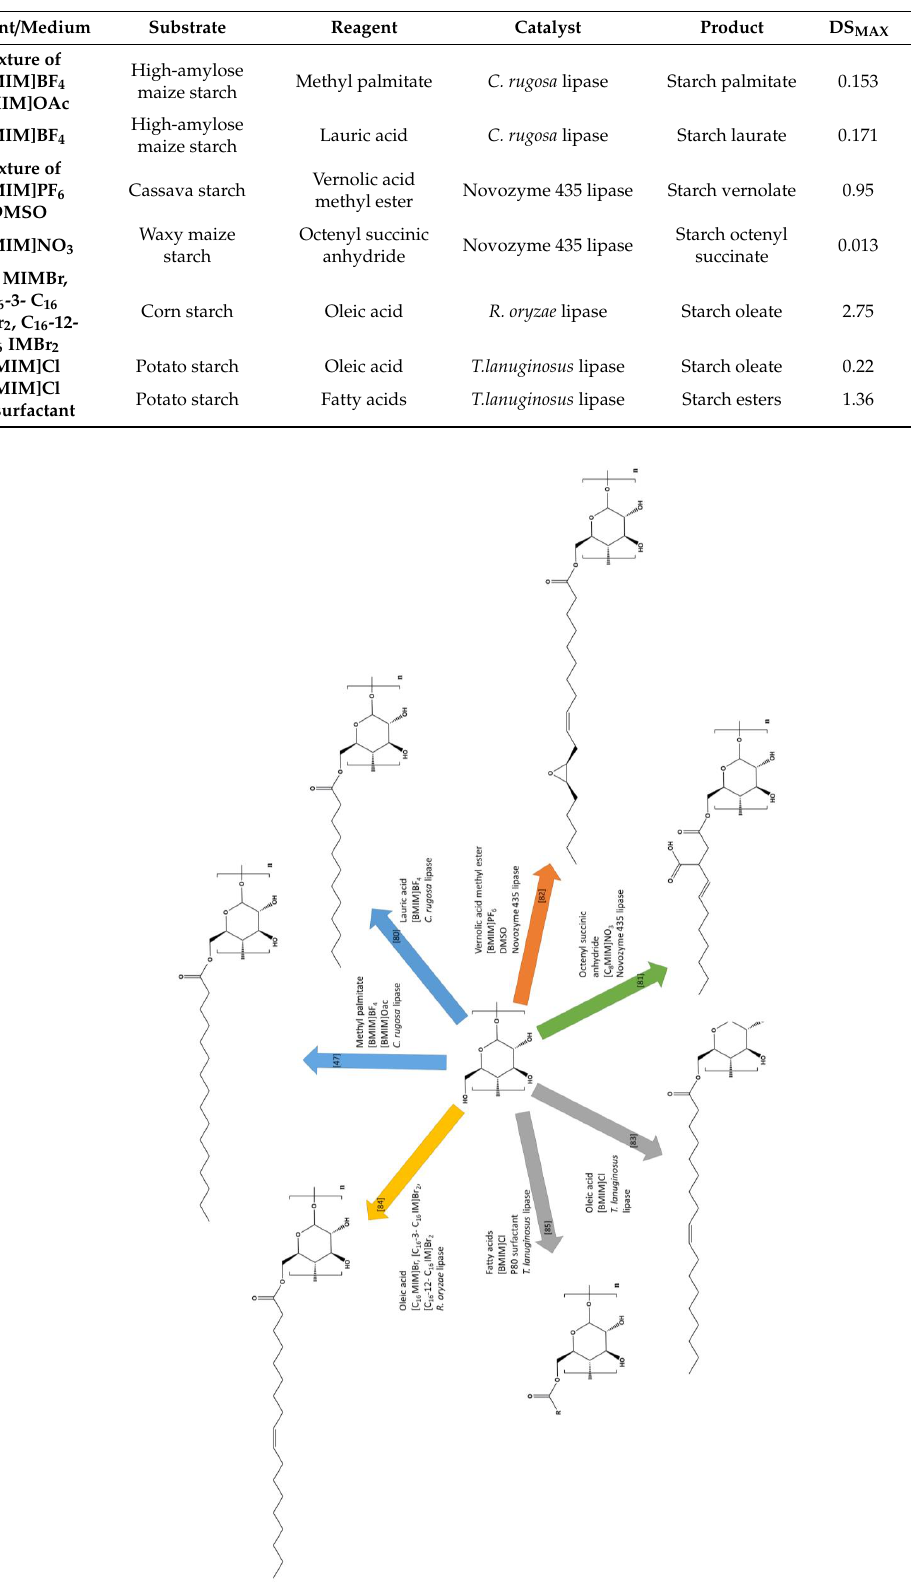
Table 4. ILs used for biocatalyzed esterification of starch.